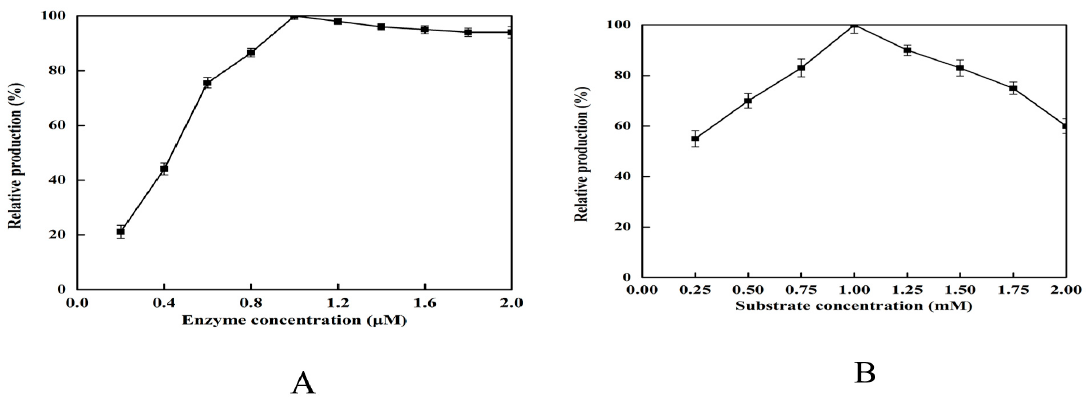
Figure 4. ( A ) Effect of enzyme concentration on the production of 2,5-DHP. The reactions were performed in 20 mM Tris-HCl buffer (pH 8.5) containing 10 mM FAD, 1 mM HSP, and 0.5 mM NADH at 30 ◦ C for 30 min; ( B ) Effect of substrate concentration on the production of 2,5-DHP. The reactions were performed in 20 mM Tris-HCl buffer (pH 8.5) containing 10 mM FAD, 1.0 µ M enzyme, and 0.5 mM